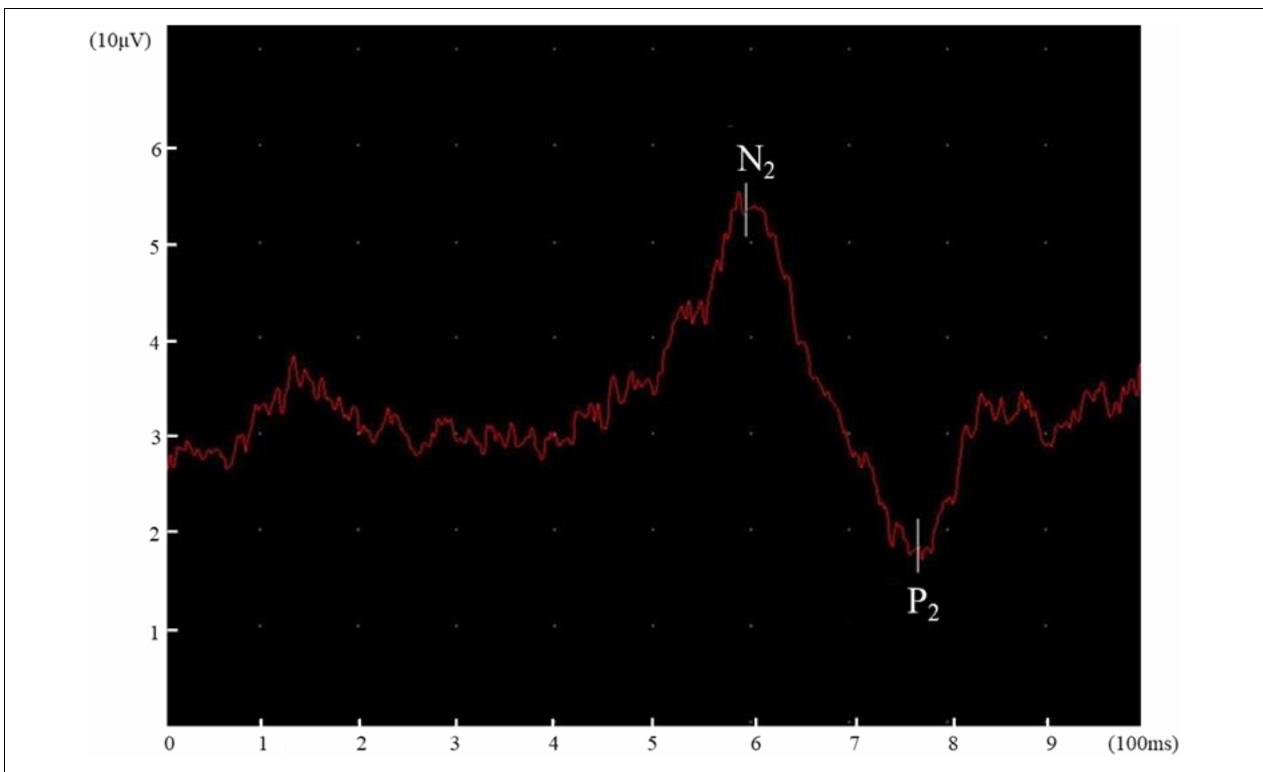
FIGURE 3 | The average CHEPs trace (3 stimuli were averaged) at the right LE.